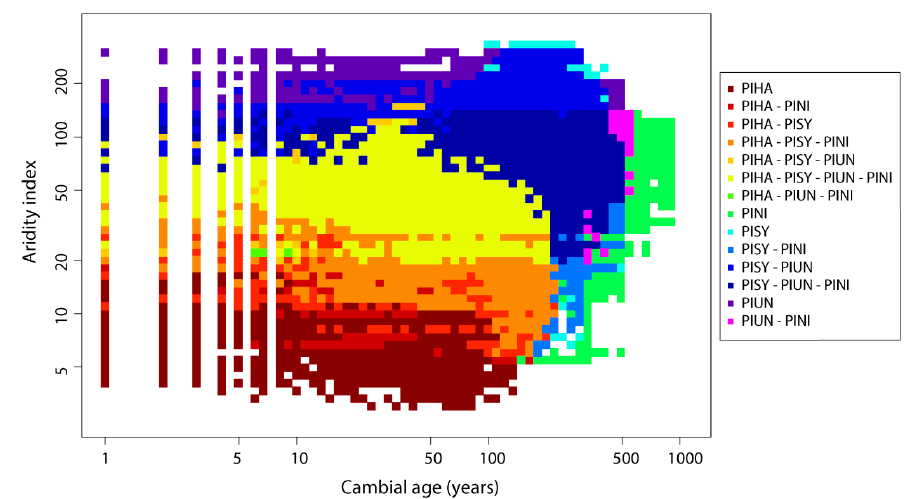
Figure 3. Matrix range of aridity gradient and age (AI-AGE) describing the space where species are present and/or coexist.